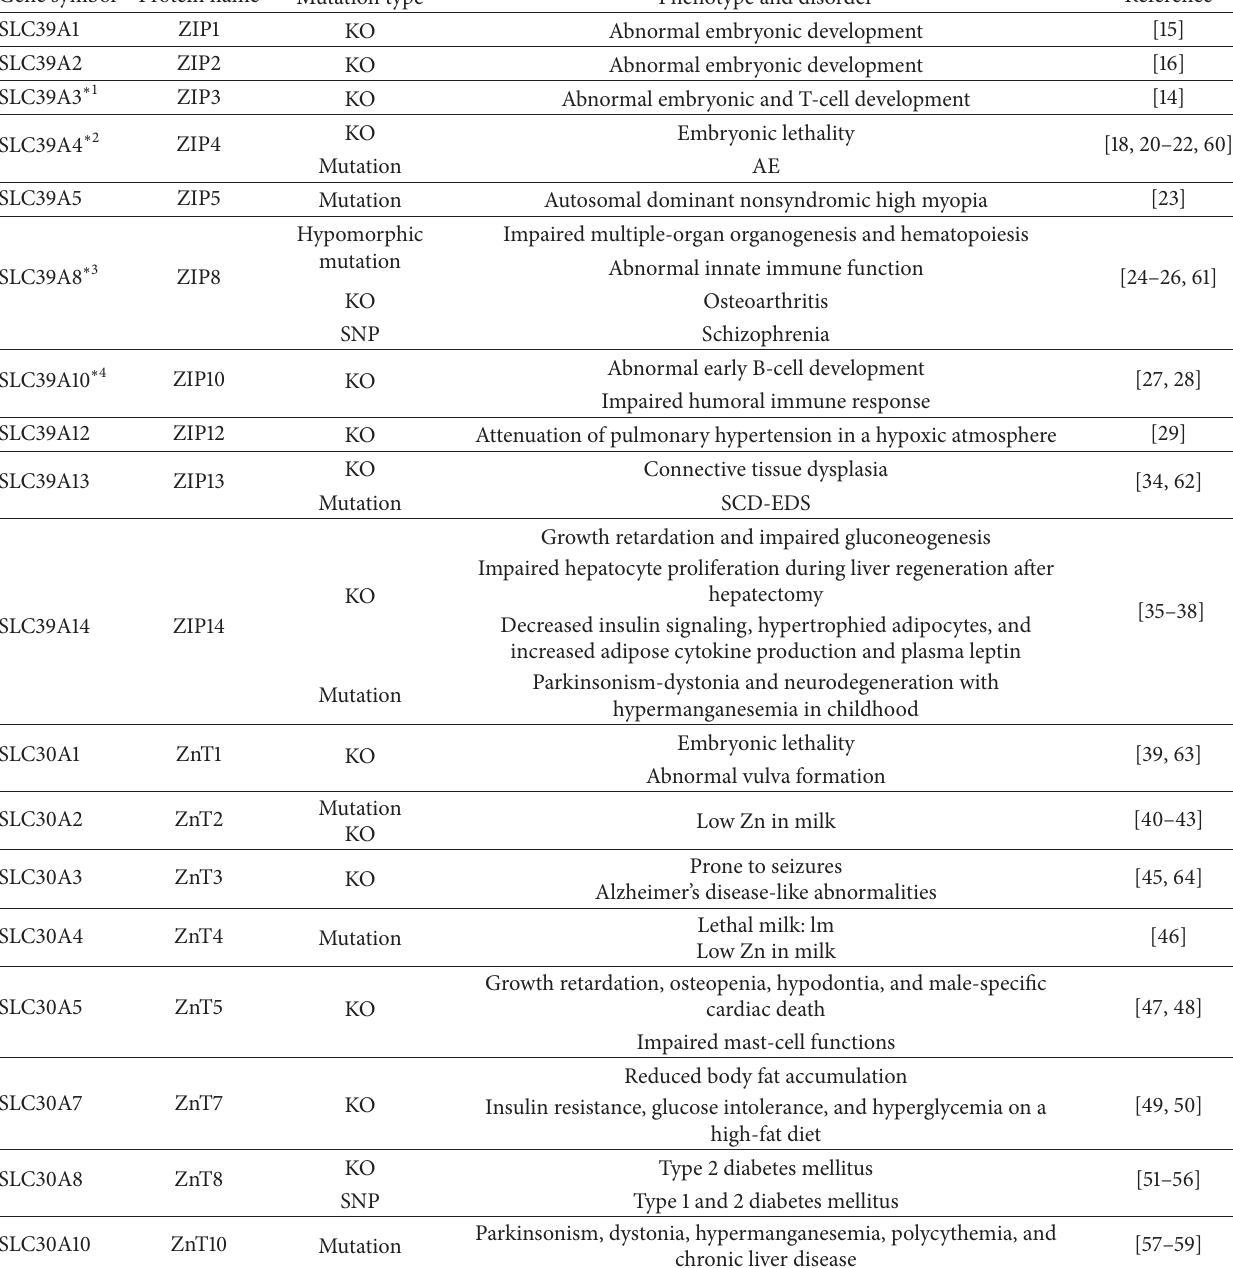
Table 1: Zn transporters in physiology and